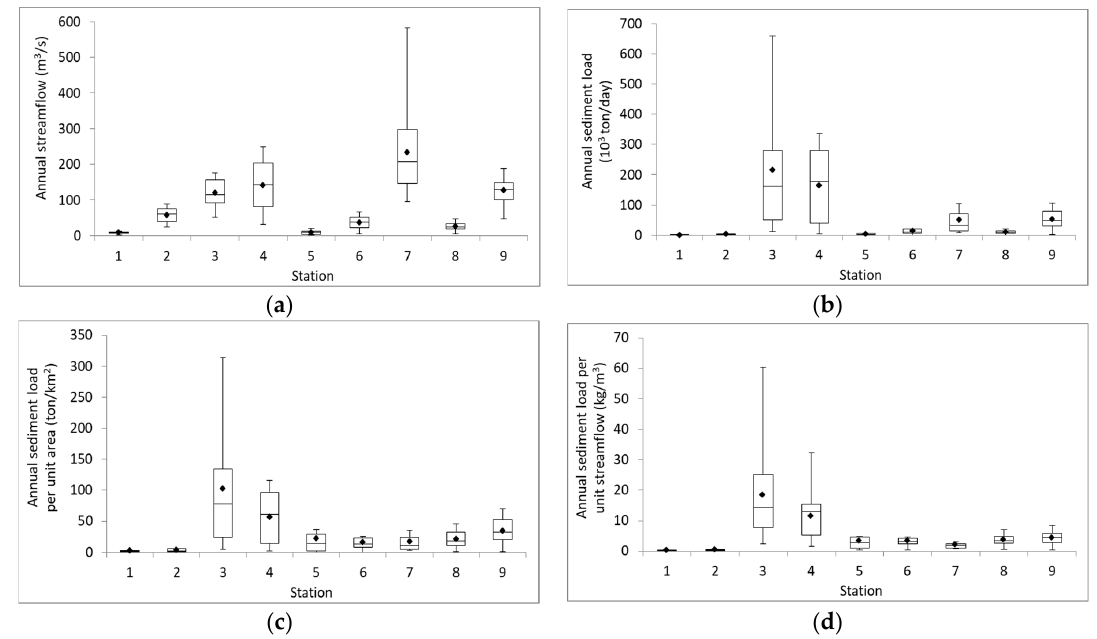
Figure 7. Spatial variation of annual streamflow and sediment load. ( a ) Annual streamflow; ( b ) Annual sediment load; ( c ) Unit-area sediment load; ( d ) Unit-flow sediment load (Note: dots denote the average value of the data).